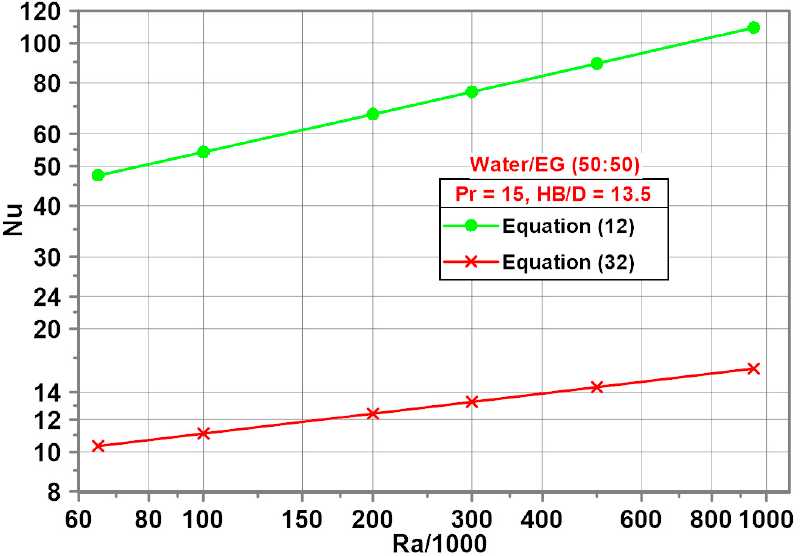
Figure 10. Present Nu-Ra relationship vs. predictions from literature correlation which relates Nusselt number to Rayleigh number and dimensionless bottom wall spacing. Nusselt number to Rayleigh number and dimensionless bottom wall